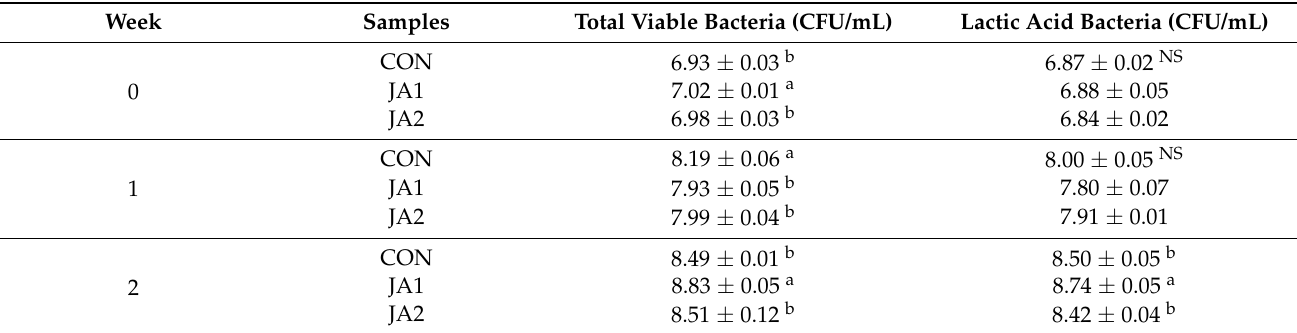
Table 7. Microbial changes of kimchi prepared with jeotgal